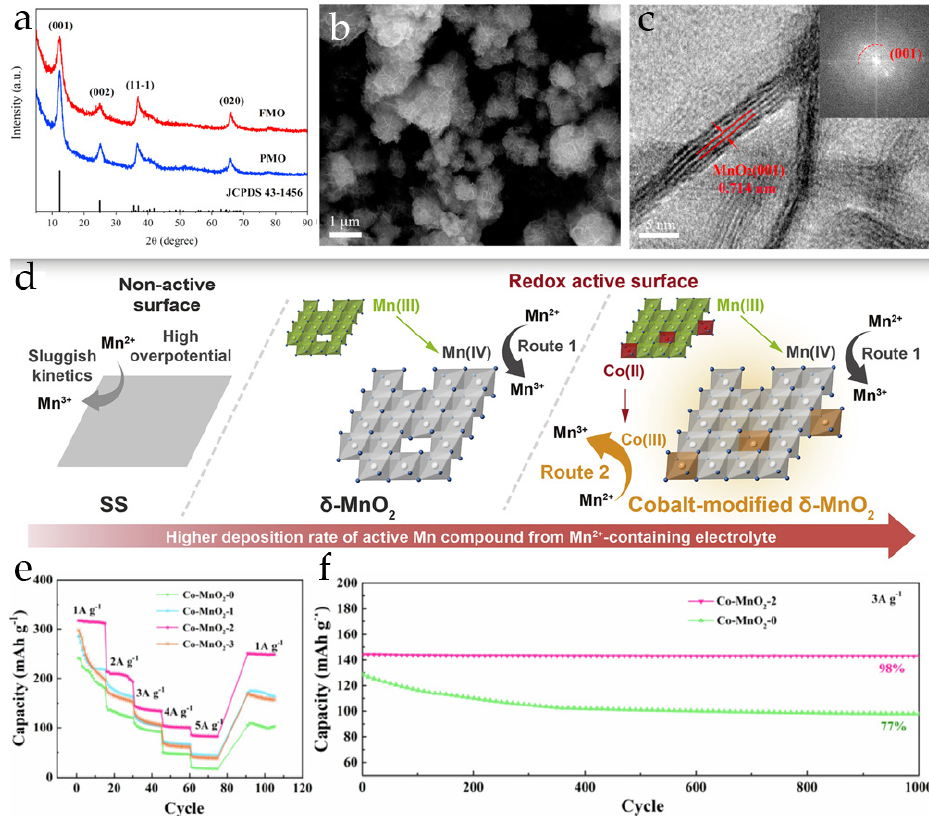
Figure 6. ( a ) XRD spectra of pristine MnO 2 and FMO [44]. ( b ) SEM image of FMO [44]; ( c ) HRTEM image of FMO [44]. ( d ) The mechanism of the catalysis effect in Co-modified δ -MnO 2 [45]. ( e ) Rate performance of plasma-treated Co-MnO 2 -X (X = treatment time) at current densities 1–5 A·g − 1 [29]. ( f ) Cycling performance of Co-MnO 2 -0 and Co-MnO 2 -2 at 3 A·g − 1 [29].